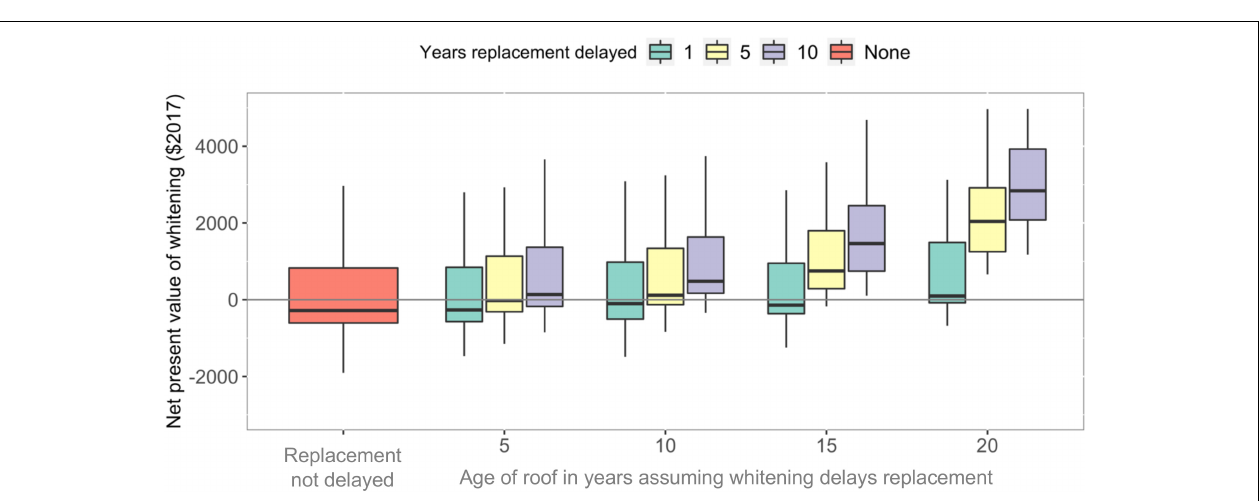
FIGURE 4 | Simulated per household net present values from coating roofs in homes represented by the sample. Positive values reflect a net savings. Results are shown assuming whitening does not delay roof replacement (far left) and does delay replacement for different roof ages. Ranges reflect the first and third quartile values and include uncertainty and variability summarized in Table 2 . Results are shown for a discount rate of 5%. Similar results for discount rates of 3% and 7% are included in the Supplementary Information